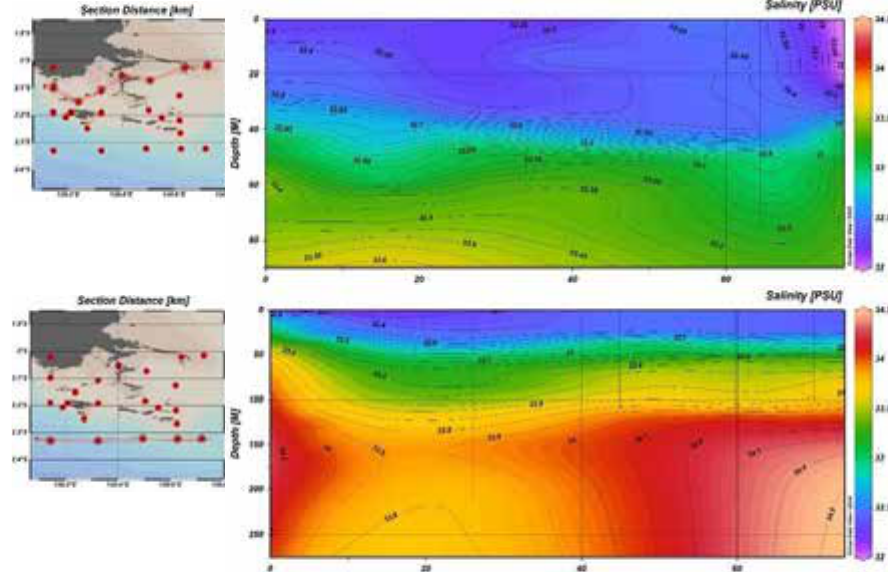
Fig. 4: The observation of spatial vertical salinity of Misool waters